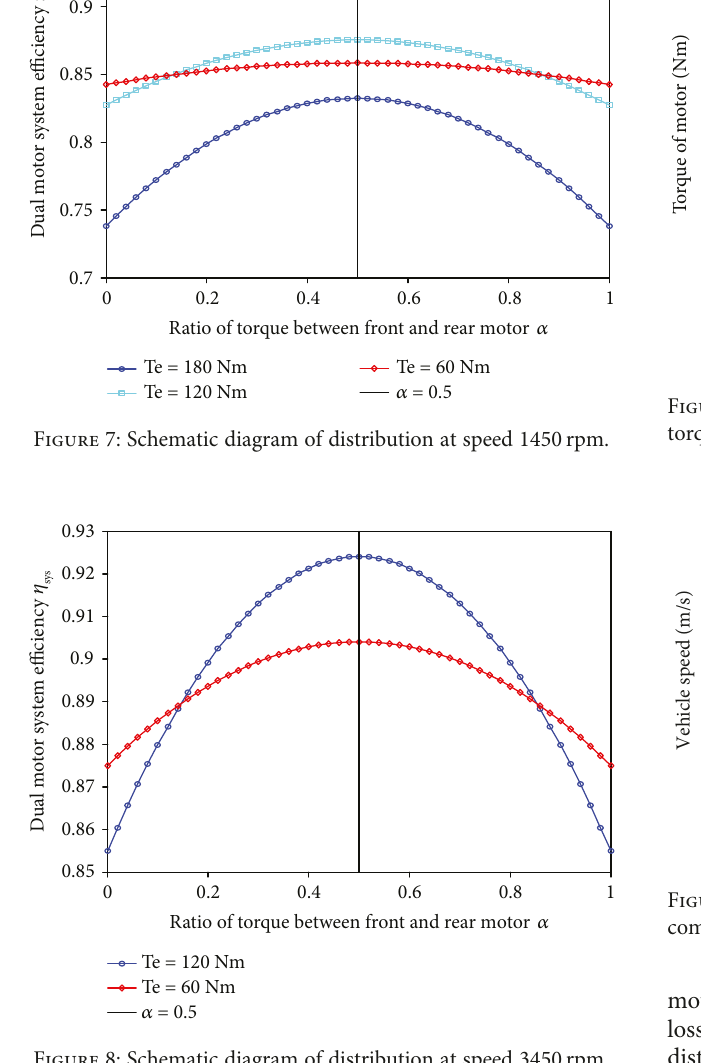
Figure 8: Schematic diagram of distribution at speed 3450 rpm.